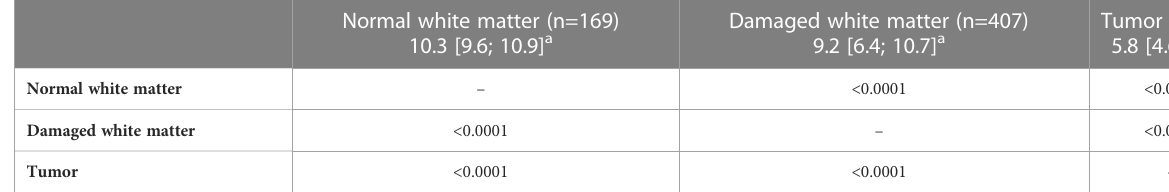
TABLE 2 Comparison of the studied tissue types using Att(co) coef fi cient.